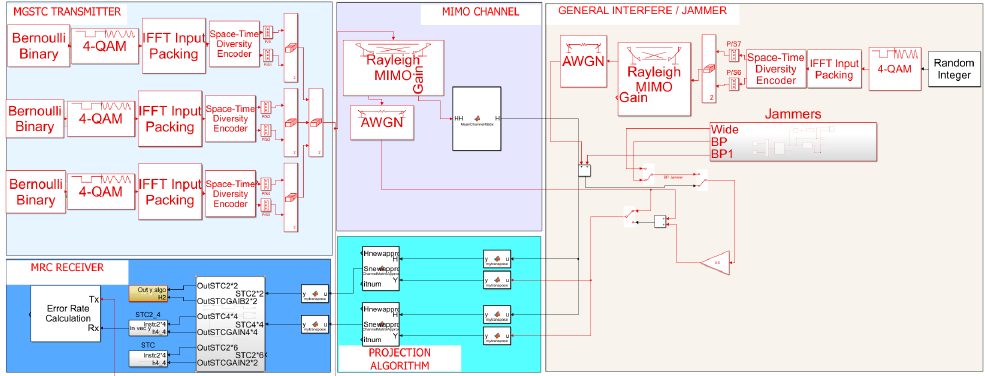
Figure 3. Scheme blocks of the simulation of the AP-HSIC based on the SIMULINK/MATLAB platform.